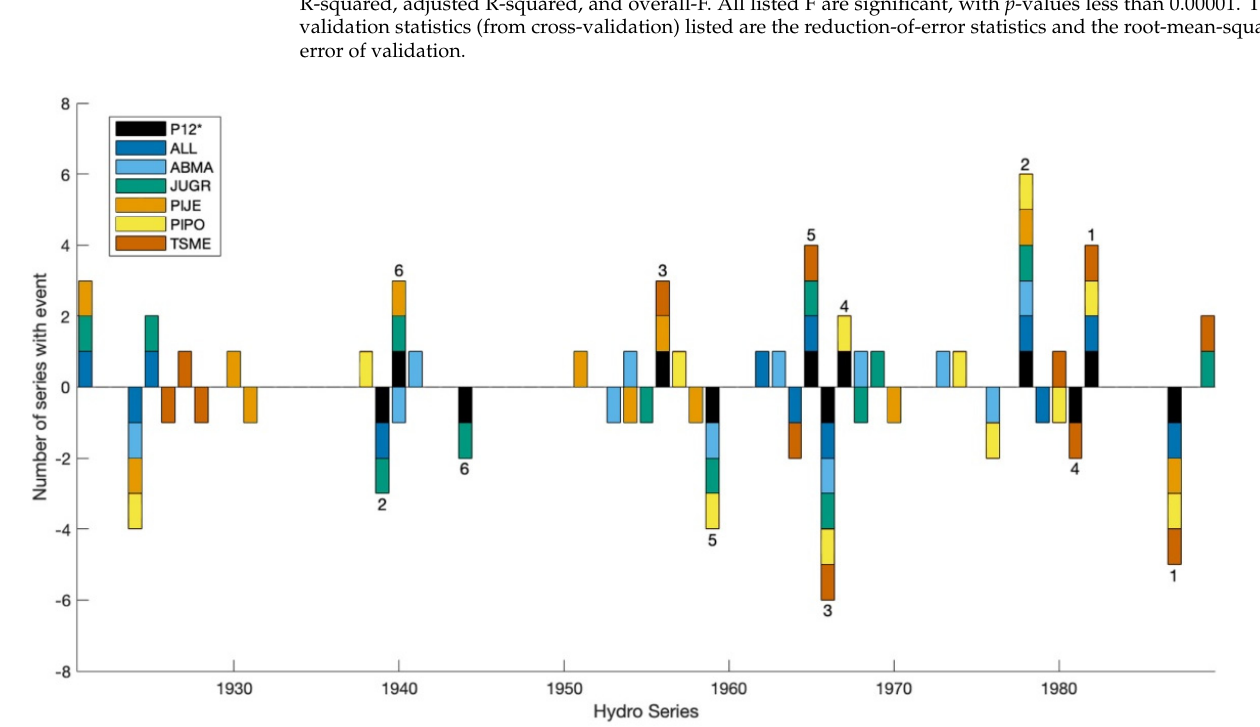
Figure 3. Whiplash events in observed regional precipitation (P12) and in species-specific and full- network (All) reconstructions, 1921–1989. Bars are plotted at the second year of the event. Positive events are above the x axis, and negative events below. Numbers above and below bars are ranks of positive and negative events in observed P12 as defined in text. The asterisk indicates that the annotated ranks apply to P12, and so ranks appear only when P12 is one of the stacked bars. Results for the hypergeometric test indicate that, with a few exceptions, the number of matches of P12 events by events in the reconstructions is greater than expected by chance (Figure 4, Table 3). p -values for the full-network and most species-specific reconstructions fall between 0.001 and 0.0001. The JUGR reconstruction for negative events stands out for the strongest tracking. Two reconstructions have insignificant tracking of P12 whiplash events: PIJE for negative events and ABMA for positive events. The scatter of points for positive and negative events (Figure 4) does not support a relationship between tracking ability and R 2 of the reconstruction model, in that the slope of a straight line (not shown) fit to the points is not significantly different from zero for either positive or negative